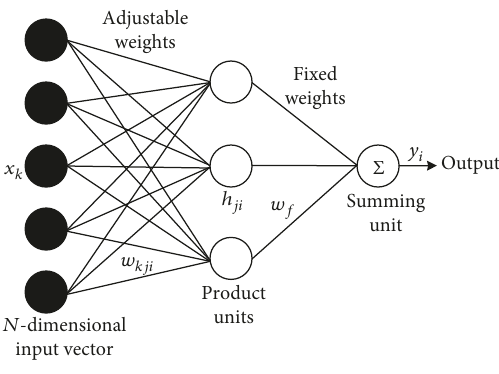
Figure 2: A sigma-pi neural